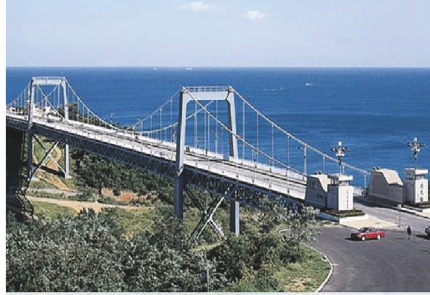
Figure 5: Dalian Northern Suspension